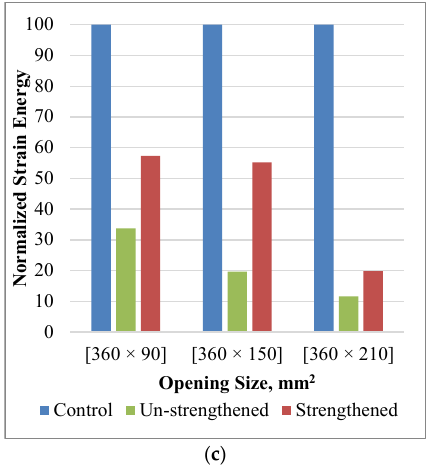
Figure 10. Energy Absorption. ( a ) tension zone opening samples; ( b ) shear zone opening samples; ( c ) normalized maximum energy of shear zone opening samples.